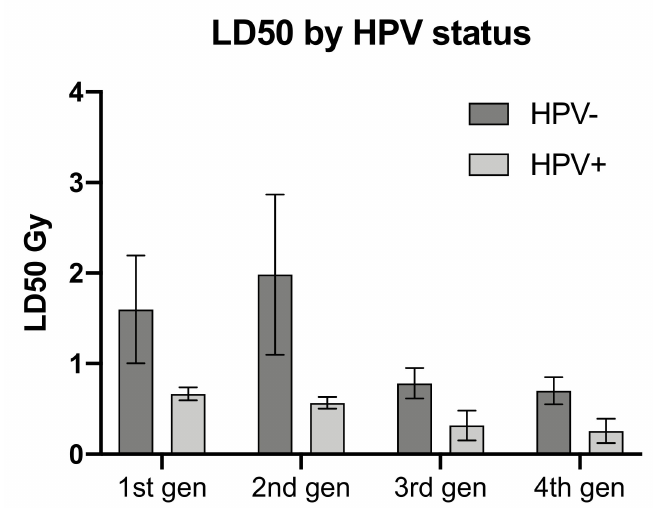
Figure 3. Comparison of dose resulting in 50% lethality (LD500 by HPV status. Error bars shown as SEM, 3 lines per HPV